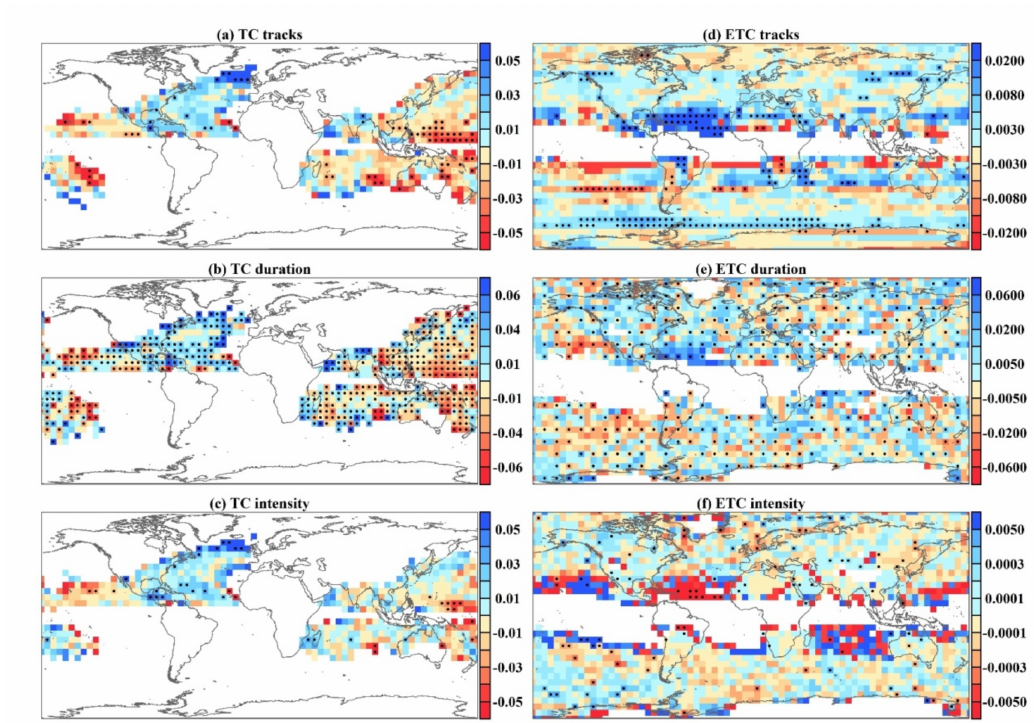
Figure 9. Spatial distributions of long-term changes of annual TC and ETC tracks ( a , d ), duration ( b , e ), and intensity ( c , f ) in 5 ◦ × 5 ◦ grids during 1979–2012: The trend is quantified by the Poisson (simple linear) regression, and the colored areas represent slope β 1 in Equations (1) and (3). A higher probability of increasing (decreasing) cyclone tracks and duration (intensity) is detected when β 1 is more (less) than zero. Moreover, the black dots indicate the grid with significant change rates (i.e., p ≤